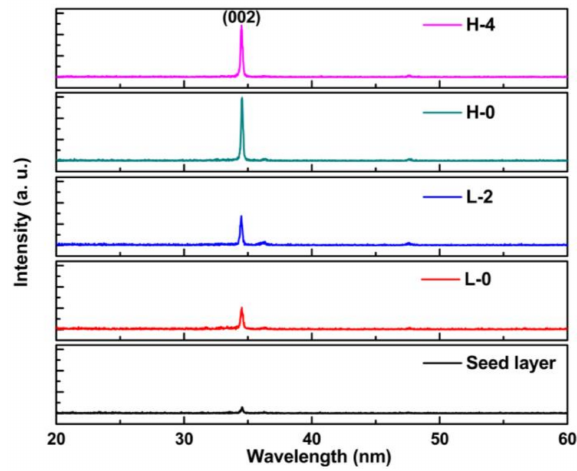
Figure 3. The XRD patterns of the seed layer and the sample L-0, L-2, H-0, and H-4.